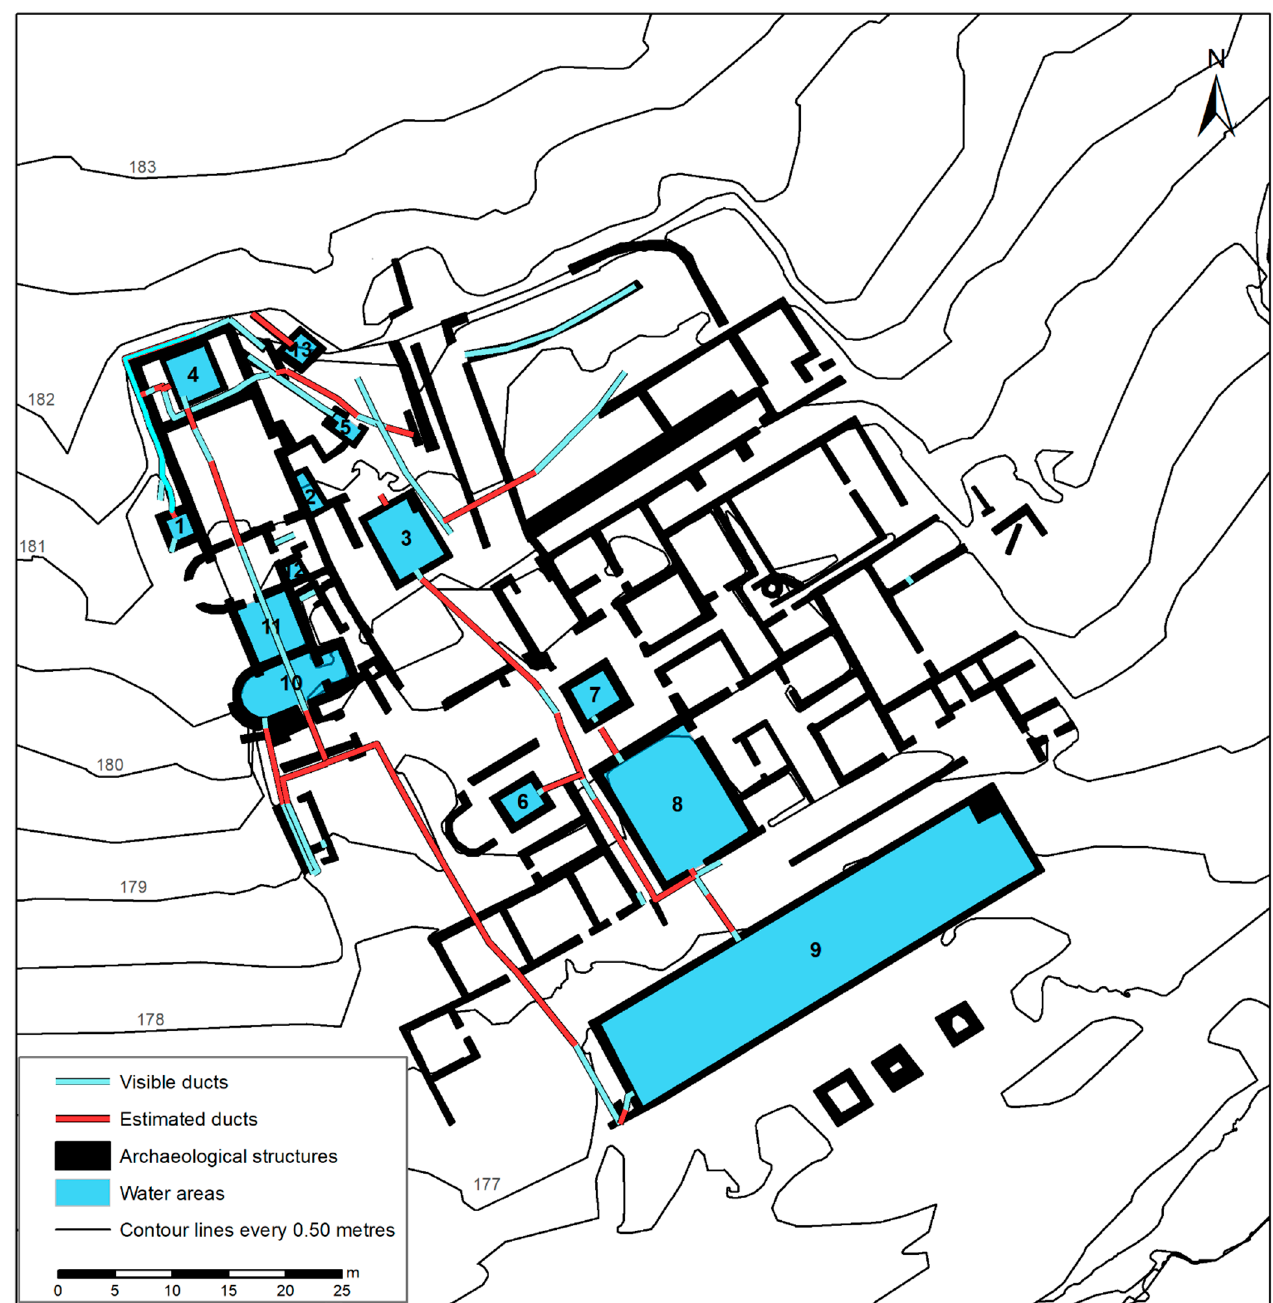
Figure 13. Location of the estimated water connections between the existing conduits (visible and those detected by geophysics).